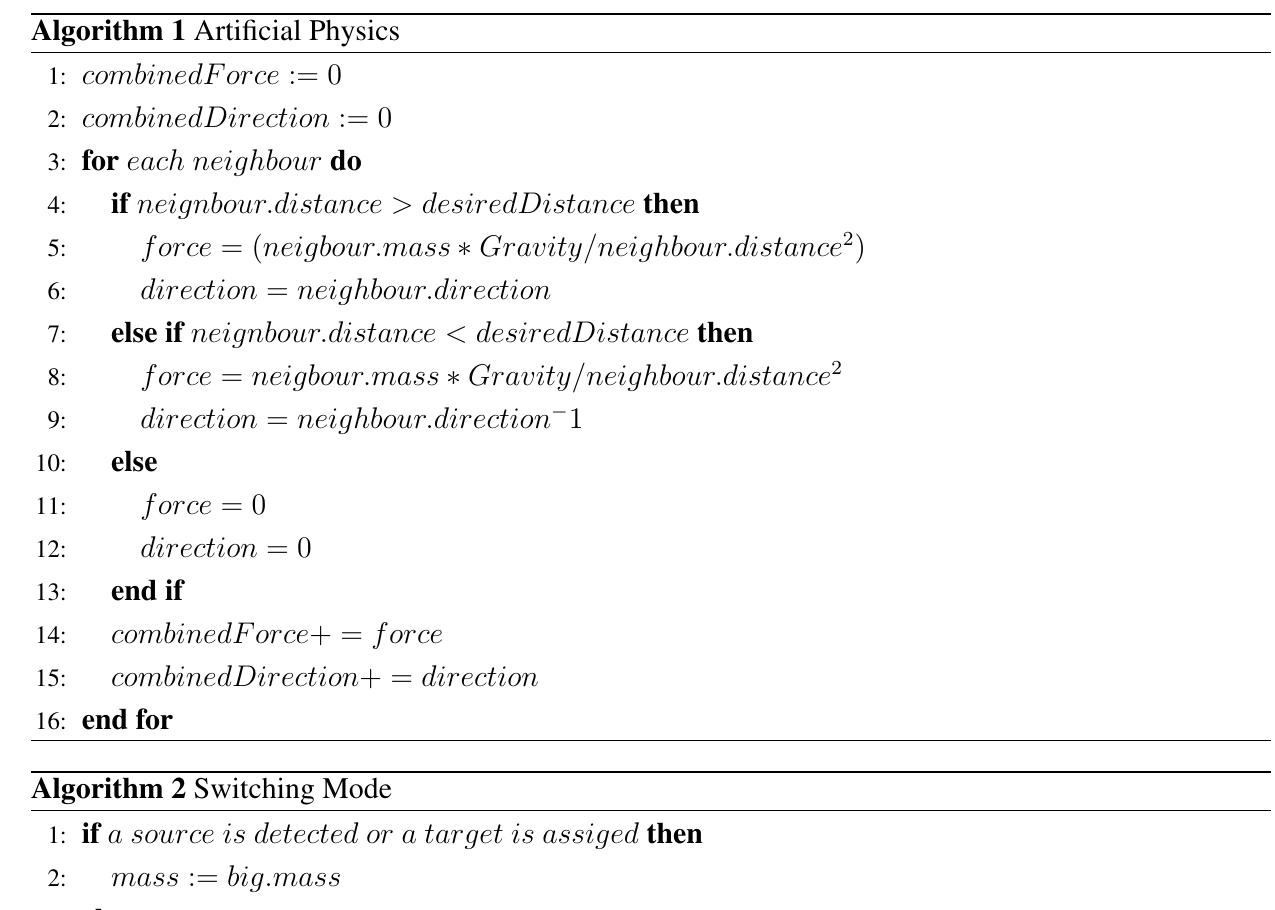
Algorithm 1 Artificial Physics